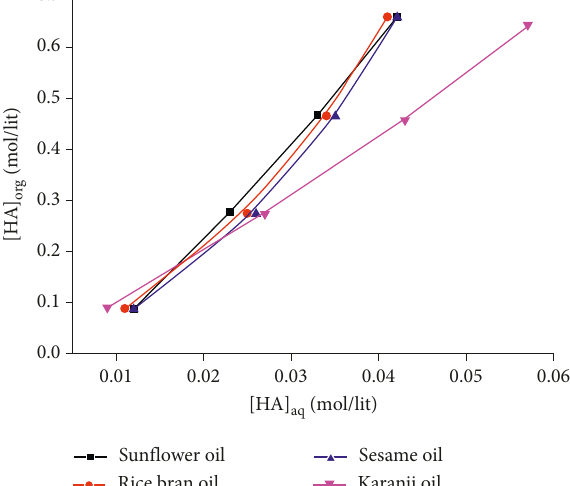
Figure 1: Reactive extraction equilibria for succinic acid using 10% TOA.